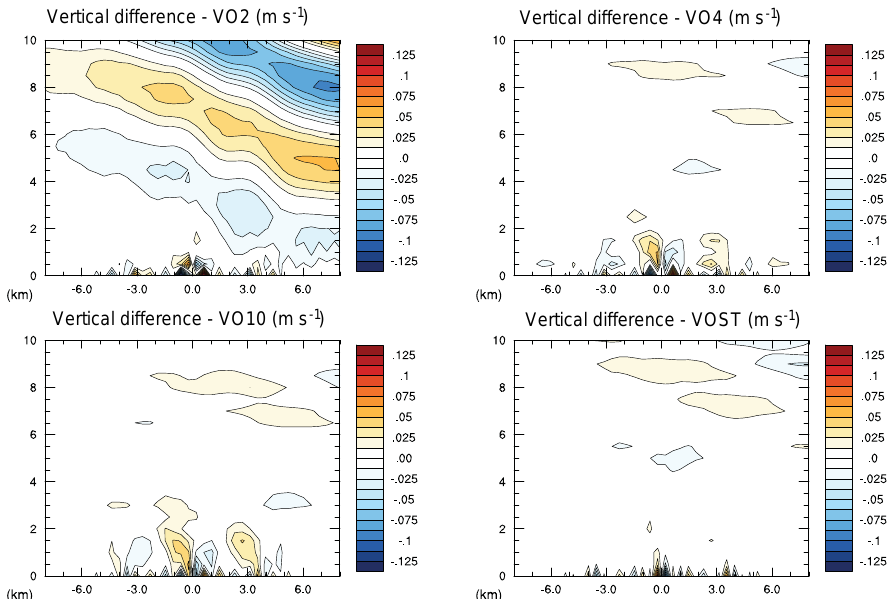
Figure 10. Schär flow steady state (10h). Vertical velocity difference with respect to the reference solution (Fig. 6, left). Results are in- terpolated to a regular z coordinate with (cid:49)z = 500m in experiments and reference solution for differencing. Computations performed at (cid:49)x = 500m and (cid:49)z = 500m. Contour interval: 0 . 0125ms − 1 .